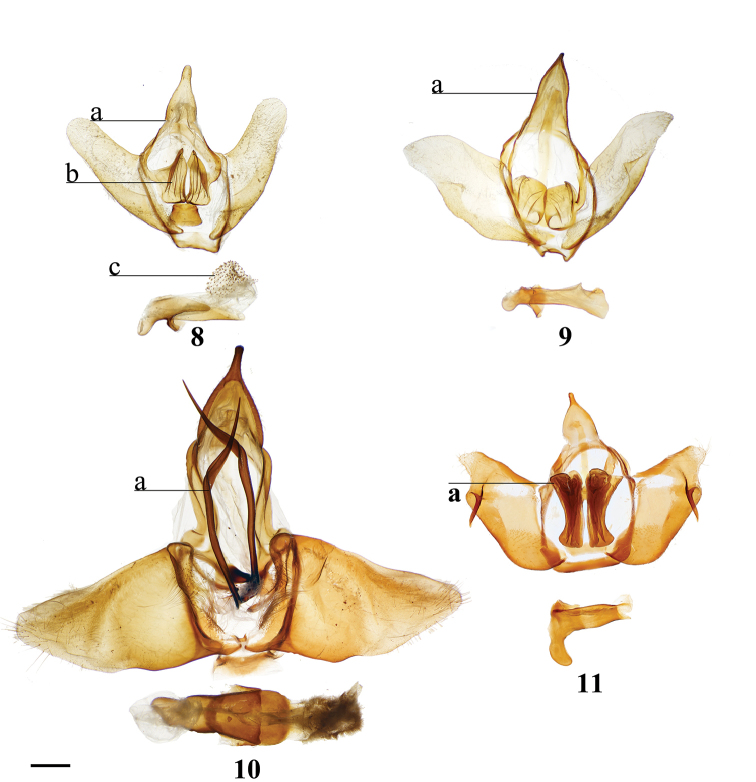
Ventral view of male genitalia of type species of genera belonging to Mimalloninae. Phallus/juxtal complex is figured below the genitalia in the lateral view, except where noted. 8Eadmunaesperans, St Laurent diss.: 3-17-18:6 (CRAS) 9Macessogacffabia, St Laurent diss.: CPC 1 (CRAS) 10Mimalloamilia, St Laurent diss.: 10-5-17:8, phallus oriented dorsally [reused with permission from St Laurent et al. (2018a), Systematic Entomology] (CRAS) 11Tostalloalbescens, St Laurent diss.: 10-21-15:4 [reused with permission from St Laurent and Mielke (2016), ZooKeys] (NHMUK). Scale bar: 1 mm.